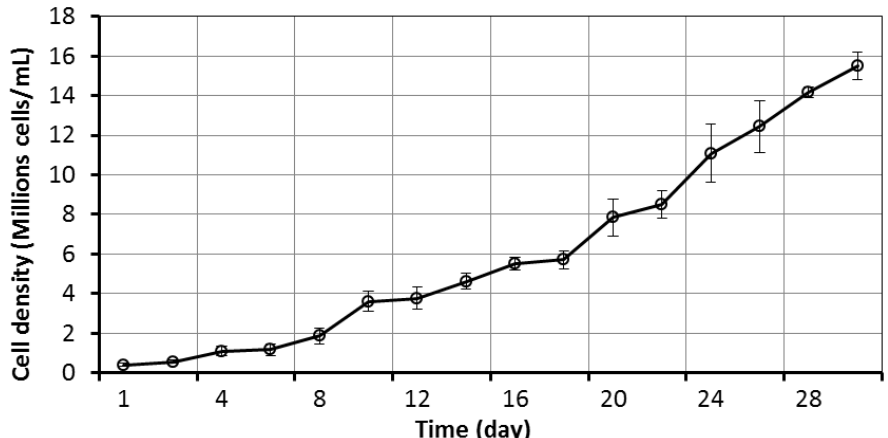
Figure 5. FWM-CV growth curve in MBL medium.